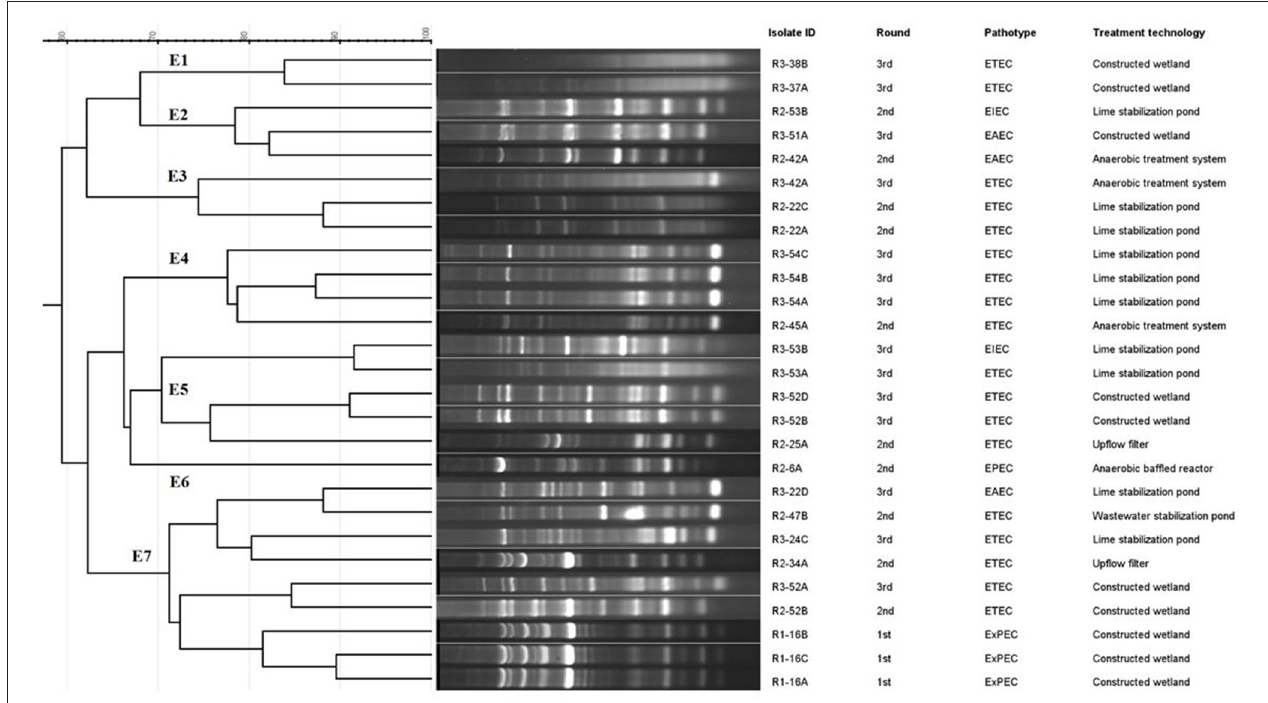
FIGURE 7 | Dendrogram of ERIC-PCR fingerprints from the pathogenic E. coli isolates. The percentage of genetic homology among banding patterns is indicated. Isolate ID, round, pathotypes and treatment technology of the plants are plotted next to